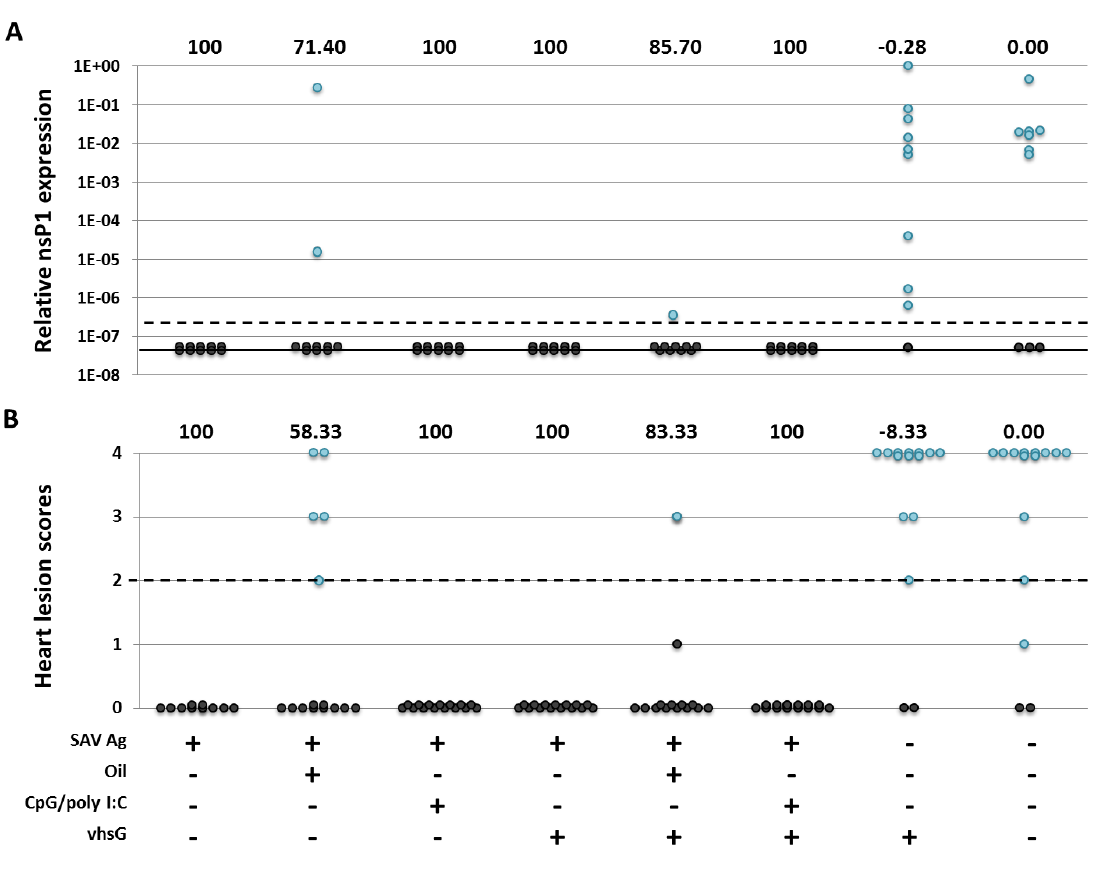
Figure 4. Protection against pancreas disease (PD) in vaccinated and control groups based on ( A ) the reduction of the prevalence of viremia and ( B ) the reduction in severity of SAV-specific heart lesions. ( A ) Relative SAV nsP1 expression at 3 wpc measured by SAV nsP1 RT-qPCR for each treatment group. Individual Cq-values were transformed to RelCq numbers, as described in the Materials and Methods. One (1.0 × 10 0 ) indicates the highest presence of nsP1 transcripts. Sera below the dotted line (cut off; 3.0 × 10 −7 ) were considered negative, and sera below the solid line had undetected Cq-values. Relative SAV nsP1 values are presented as black (<3.0 × 10 −7 ) and blue (≥3.0 × 10 −7 ) dots. ( B ) The distribution of individual heart lesion scores assessed by histology at 6 wpc for each treatment group. A score of ≥2 was set as the cut off (indicated by the dotted line). Individual heart lesion scores are presented as black (<2) and blue (≥2) dots. Relative percent protection score (RPPsc.) values corresponding to each group are shown above Graphs A and B. + or −, respectively, indicate the presence or absence of either the SAV Ag, oil, CpG/poly I:C or vhsG DNA